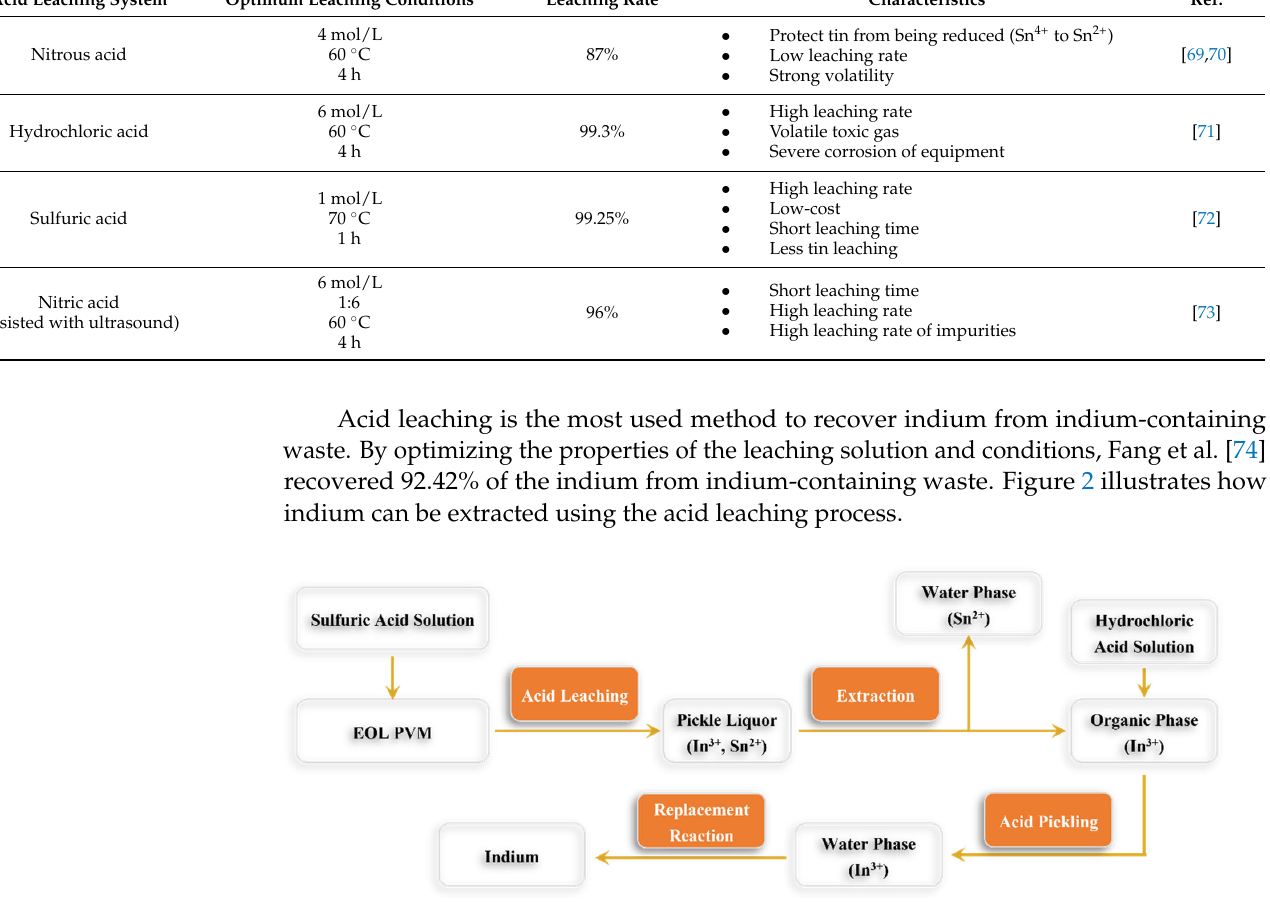
Figure 2. Flow diagram of indium extraction using the acid leaching method.